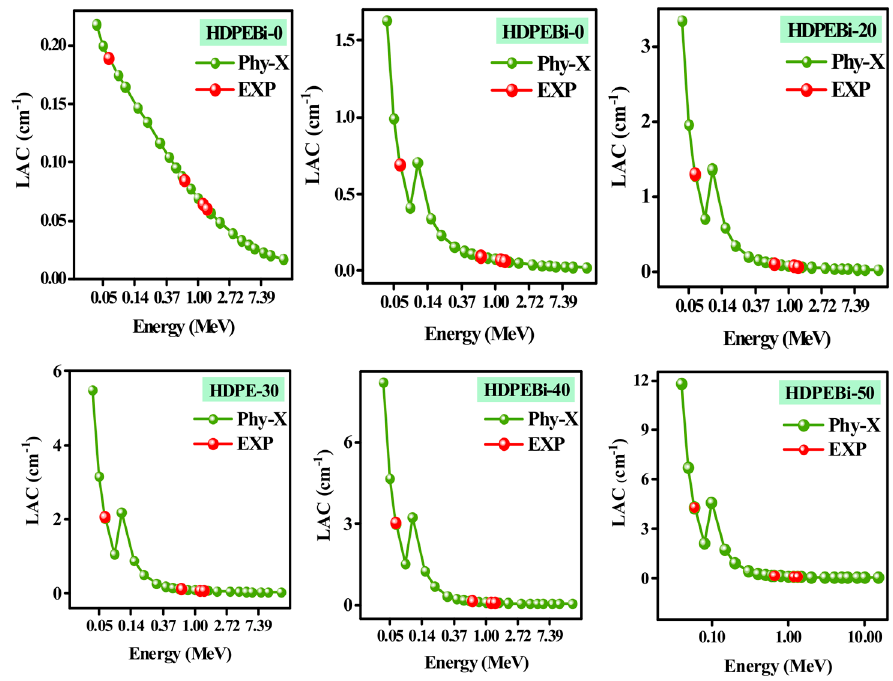
Figure 3. Linear attenuation coefficients of all prepared samples at different energies according to experimental and Phy-X results.